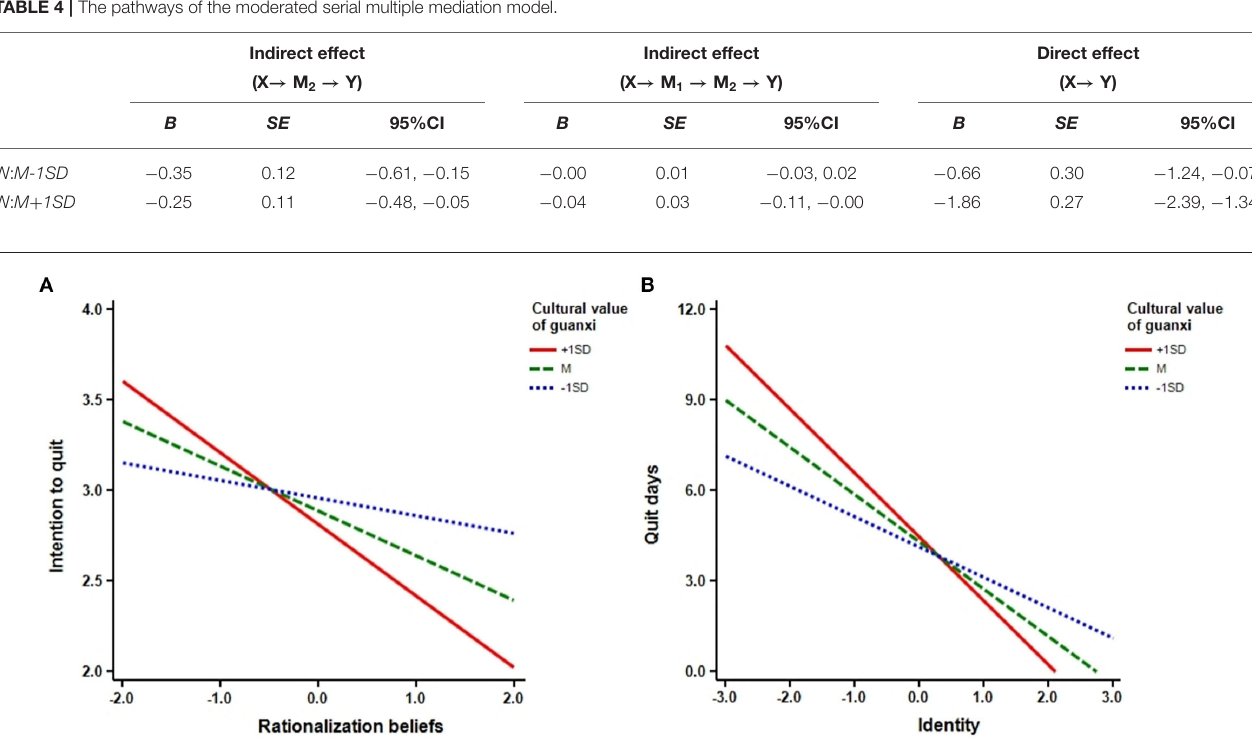
TABLE 4 | The pathways of the moderated serial multiple mediation model.